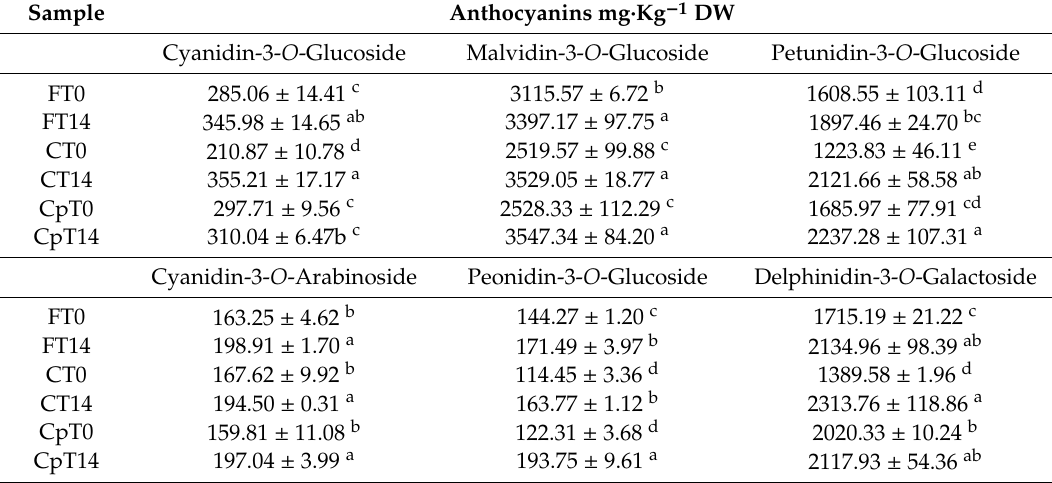
Table 3. Anthocyanin quantified in uncoated and coated blueberry samples before in vitro